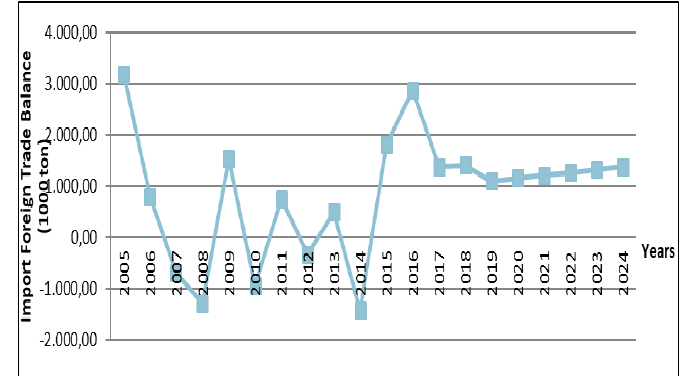
Figure 7: Wheat trade balance of Turkey Between the years 2005-